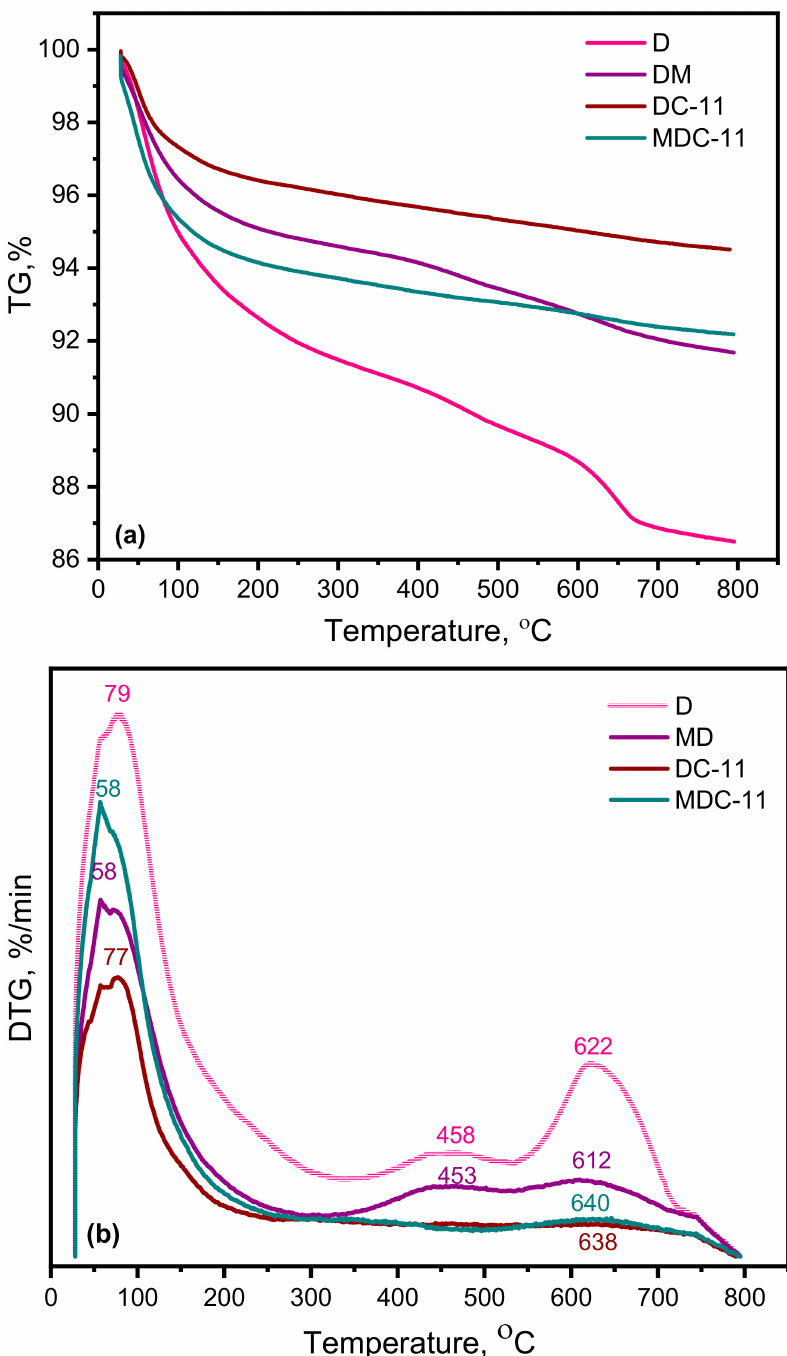
Figure 5. ( a ) TG, ( b ) DTG curves for D, DM, DC-11, and